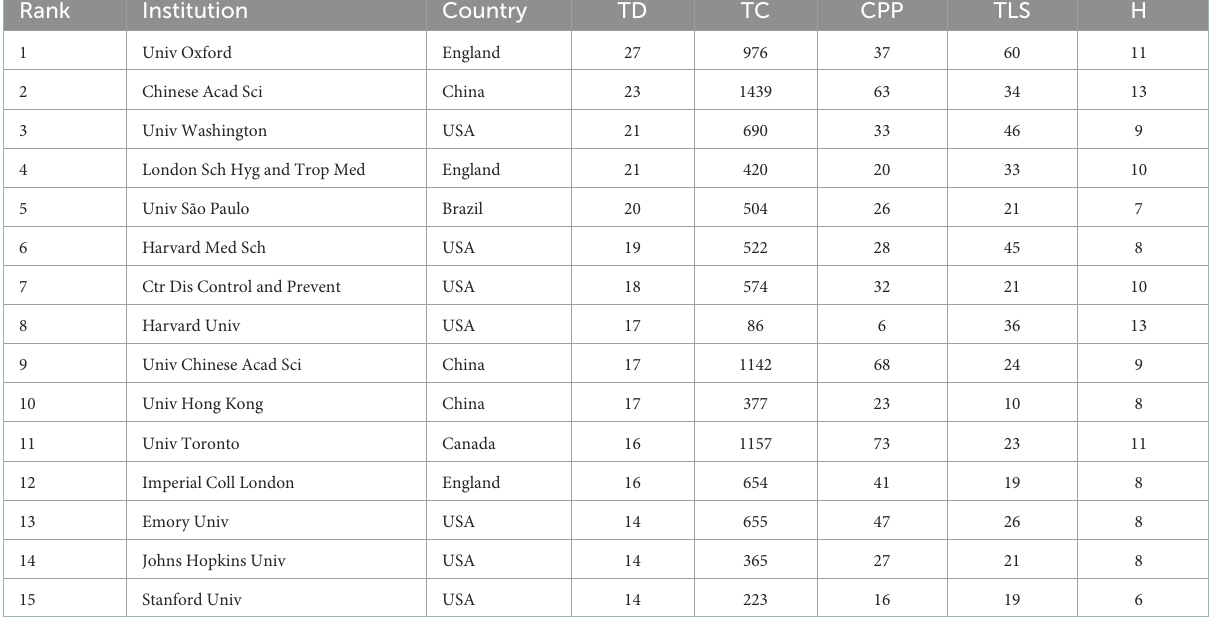
TABLE 1 Top 15 institutions with the most publication. Rank